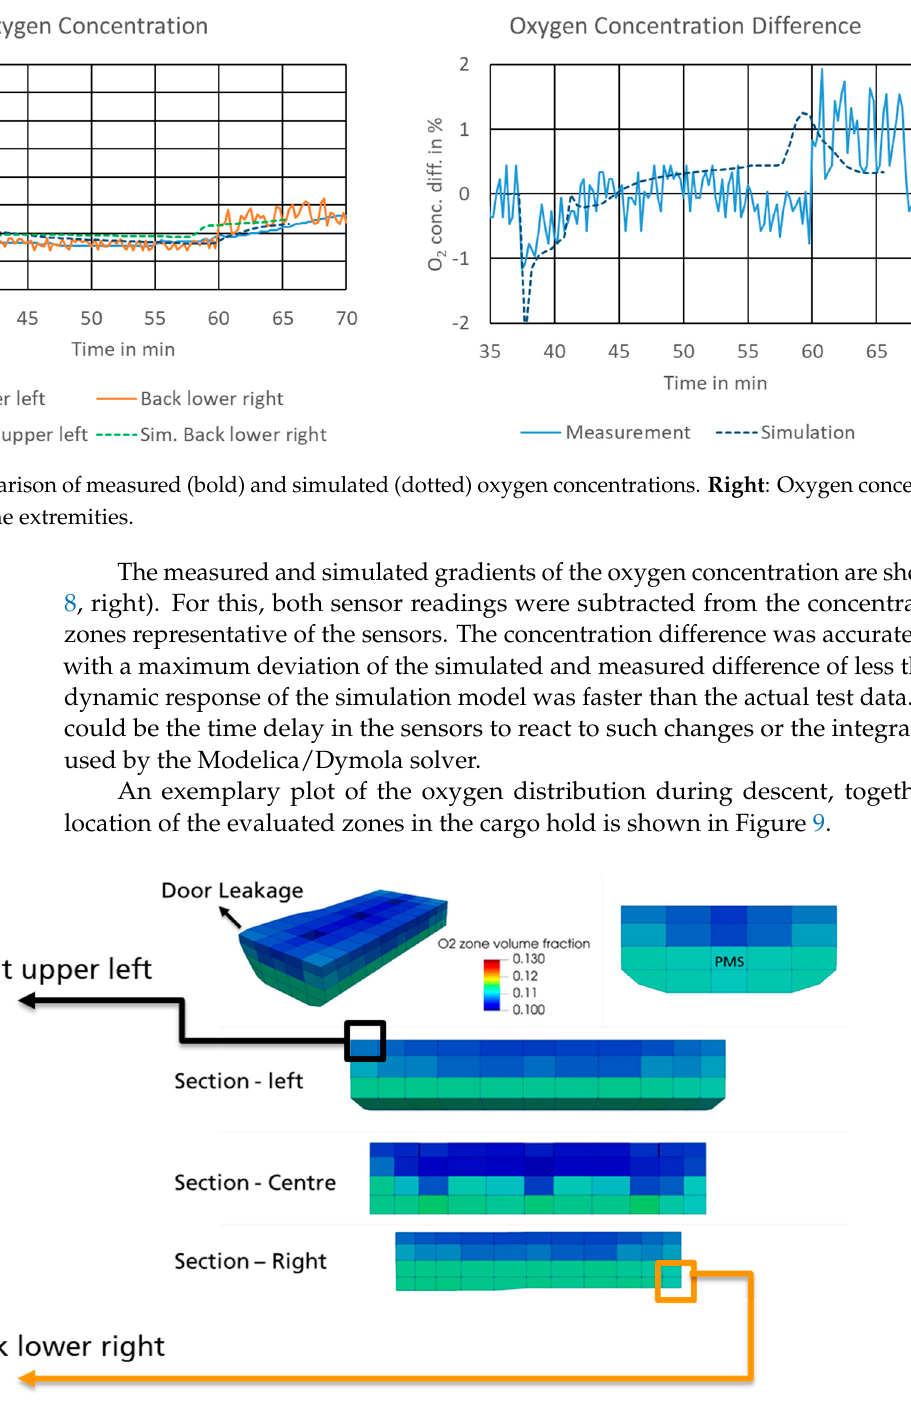
Figure 9. Simulated oxygen gradient during descent.